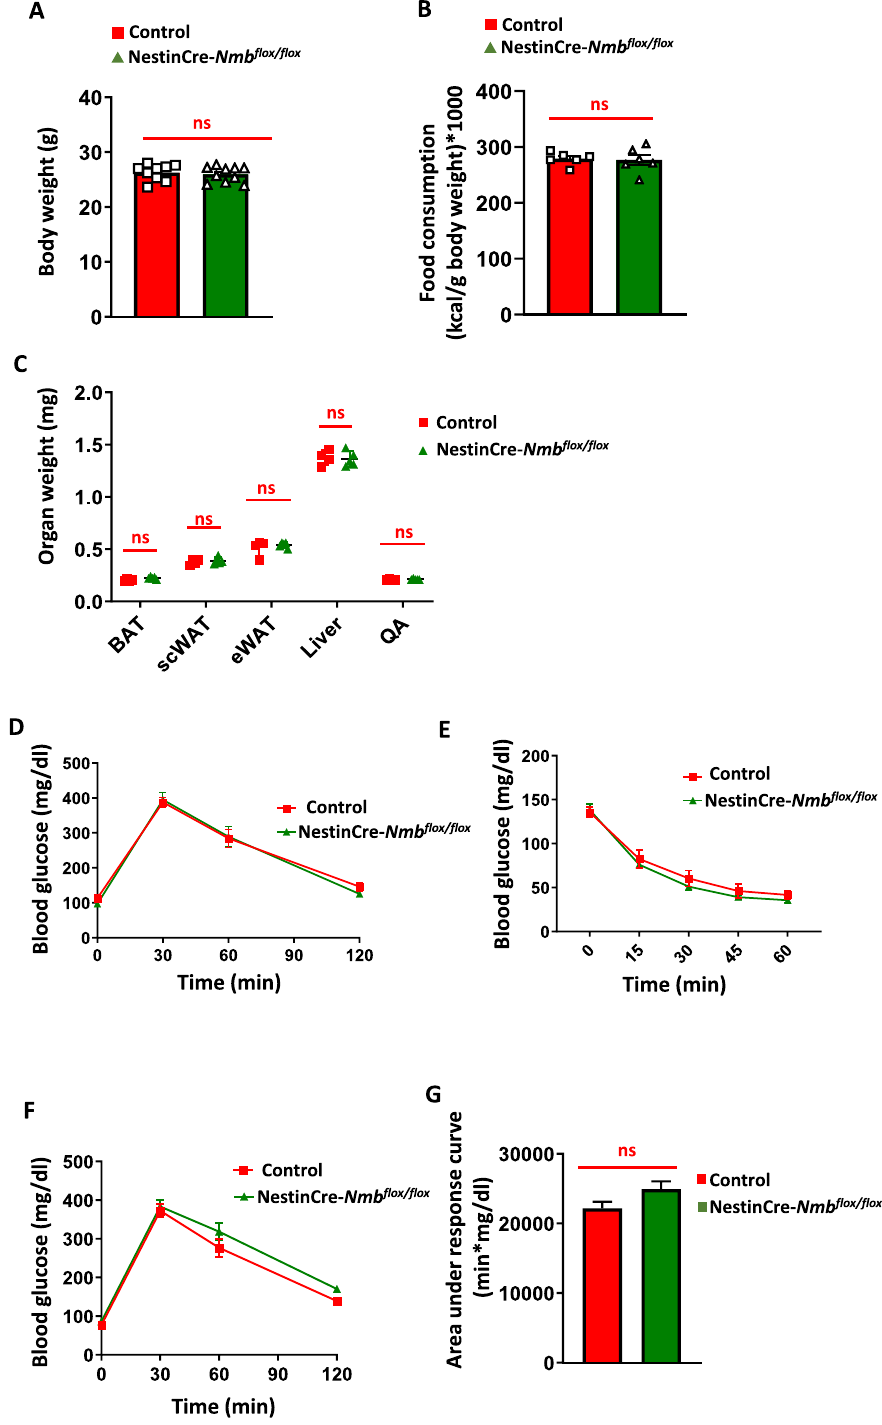
Figure 2. Nmb deficiency in the nervous system does not affect food consumption, body weight and adiposity under standard diet. ( A) Body weight of 6 month old control and NestinCre- Nmb flox/flox mice on standard diet. Each dot represents individual mice. ( B) Food consumption of 6 month old control and NestinCre- Nmb flox/flox mice on standard diet. Each dot represents individual mice. ( C) Organ weight isolated from 6 month old control and NestinCre- Nmb flox/flox mice on standard diet. n = 4 mice per group. ( D) Intraperitoneal glucose tolerance test (IP GTT) of 6 month old control and NestinCre- Nmb flox/ flox mice on standard diet. n = 6 mice per group. ( E) Intraperitoneal insulin tolerance test (IP ITT) of 6 month old control and NestinCre- Nmb flox/flox mice on standard diet. n = 6–7 mice per group. ( F) Oral glucose tolerance test (OGTT) of 6 month old control and NestinCre- Nmb flox/flox mice on standard diet. n = 8 mice per group. ( G) Area under the curve of oral